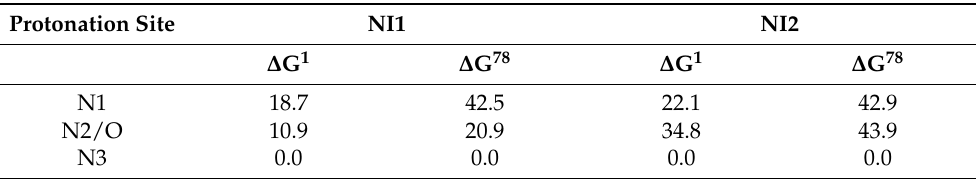
Table 6. Gibbs energy differences (ΔG) between the protonated forms of NI1 and NI2 in the gas phase (ΔG 1 ) and water (ΔG 78 ), in kcal mol −1 .